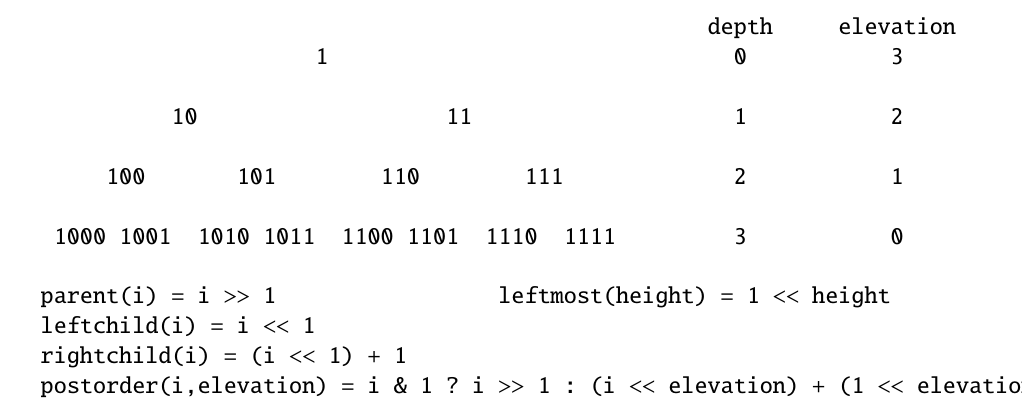
Figure 1. Height 3 complete binary tree, with nodes labelled with 1-based level order indices i in binary. Postorder traversal of a binary tree visits every node in sequence such that child nodes are visited before their parents. The simplicity of the complete binary tree data structure allows tree navigation from the bitwise manipulations of level indices. Total nodes in a complete binary tree of height h is 2 h + 1